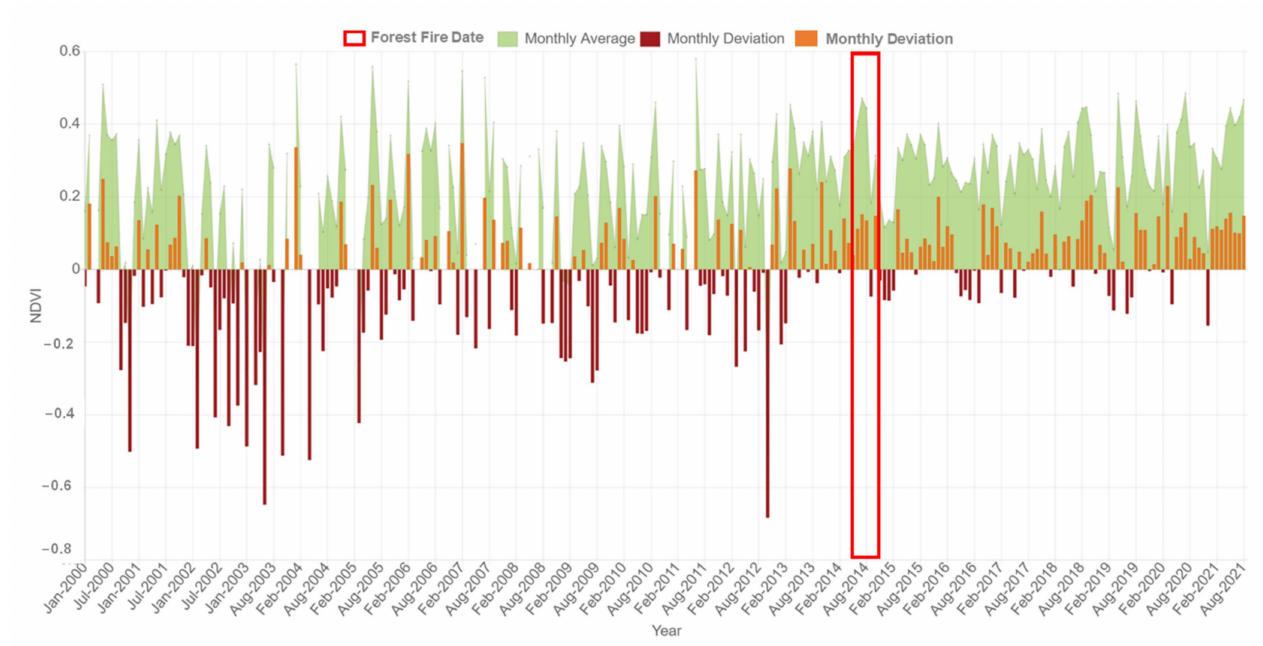
Figure 7. Monthly NDVI in Carolina parish, calculated with Landsat-8 satellite data. Source: adapted from [109].